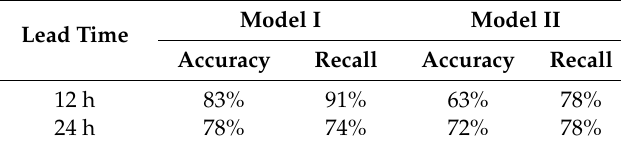
Figure 3. Probabilistic forecasting of CFW occurrence for validation data. Table 4. Forecasting performance in terms of accuracy and recall (validation data).